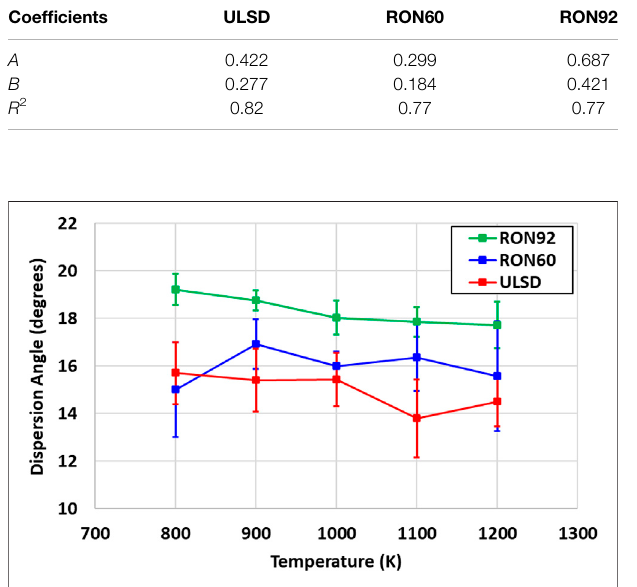
FIGURE 21 | Vaporizing dispersion angle vs. charge gas temperature at ρ 3 and P a = 23 kg/m inj = 1,500 bar.